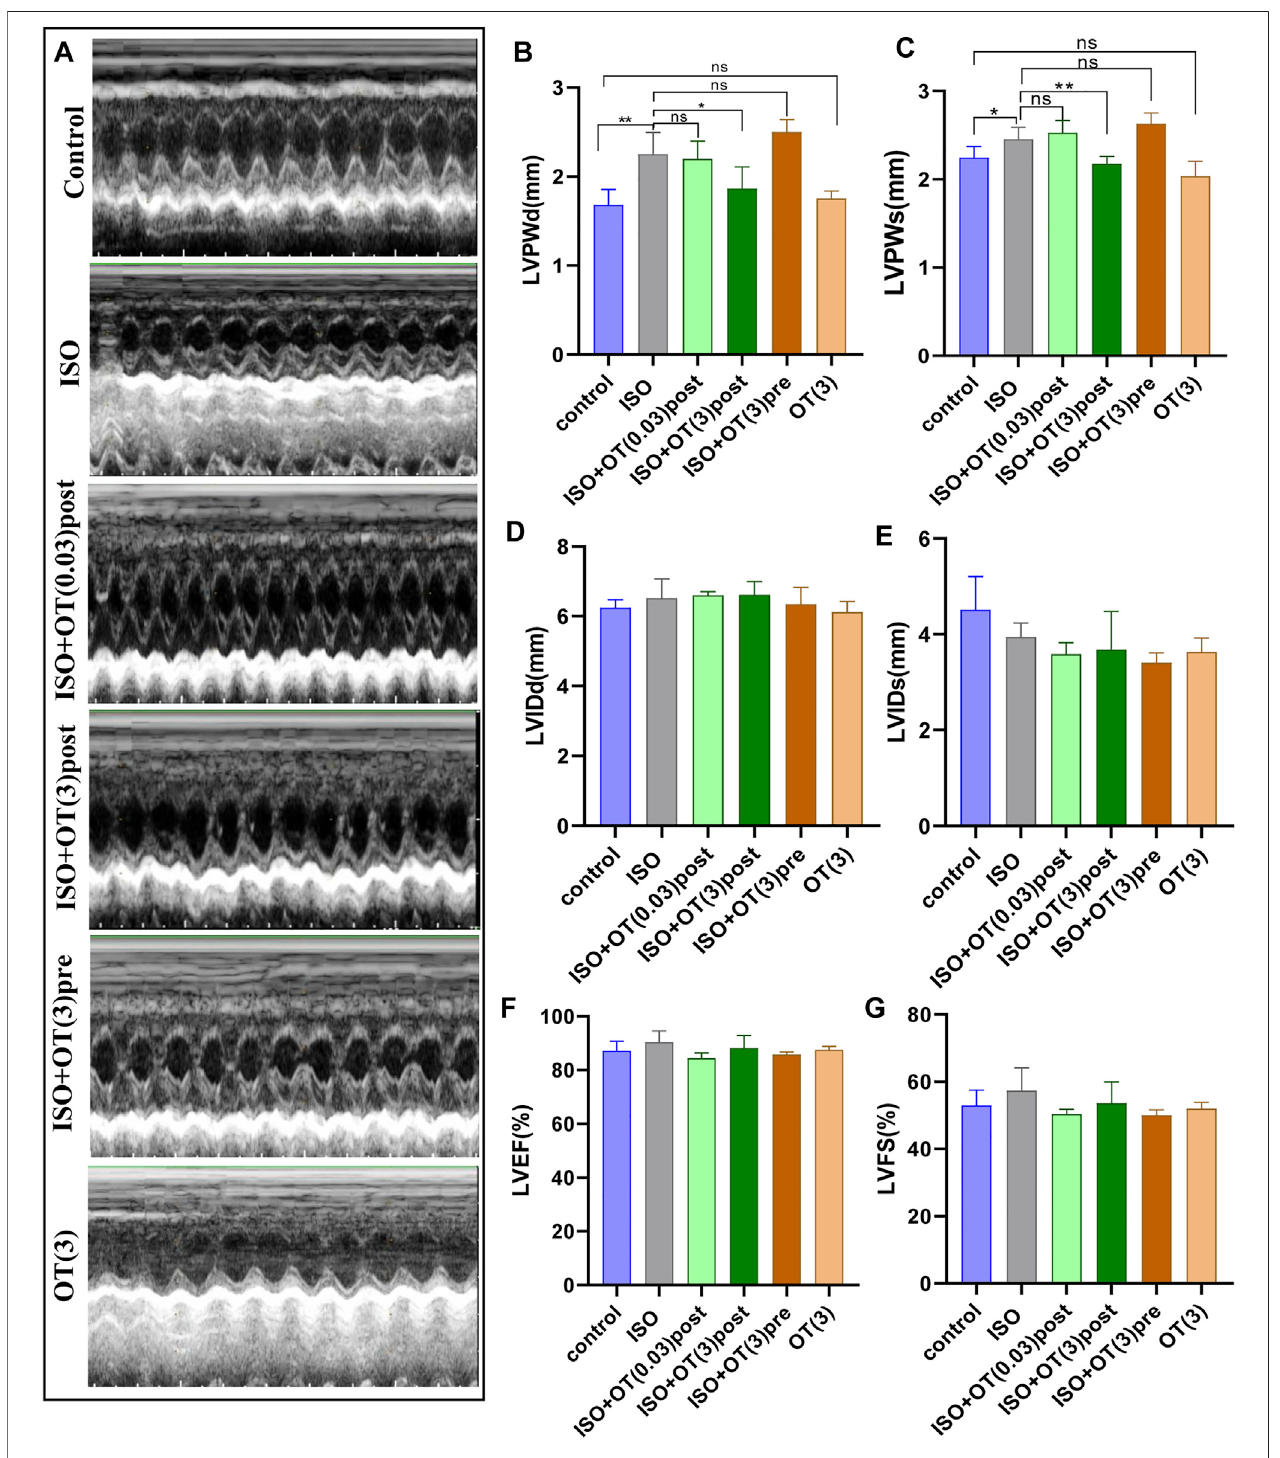
FIGURE 5 | Effects of OT on cardiac structure and functional parameters assessed by Echocardiography. (A) Representative echo images of each group. (B) LVPWd. (C) LVPWs. (D) LVIDd. (E) LVIDs. (F) LVEF. (G) LVFS. n (cid:2) 4 – 6 rats per experimental group. * p < 0.05; ** p < 0.01; ns, not signi fi cant. LVPWd, left ventricular posterior wall thickness at end-diastole; LVPWs, left ventricular posterior wall thickness at end-systole; LVIDd,Leftventricular internal diameter end-diastole; LVIDs, Left ventricular internal diameter end-systole; LVEF, left ventricular ejection fraction; LVFS, left ventricular fractional shortening.